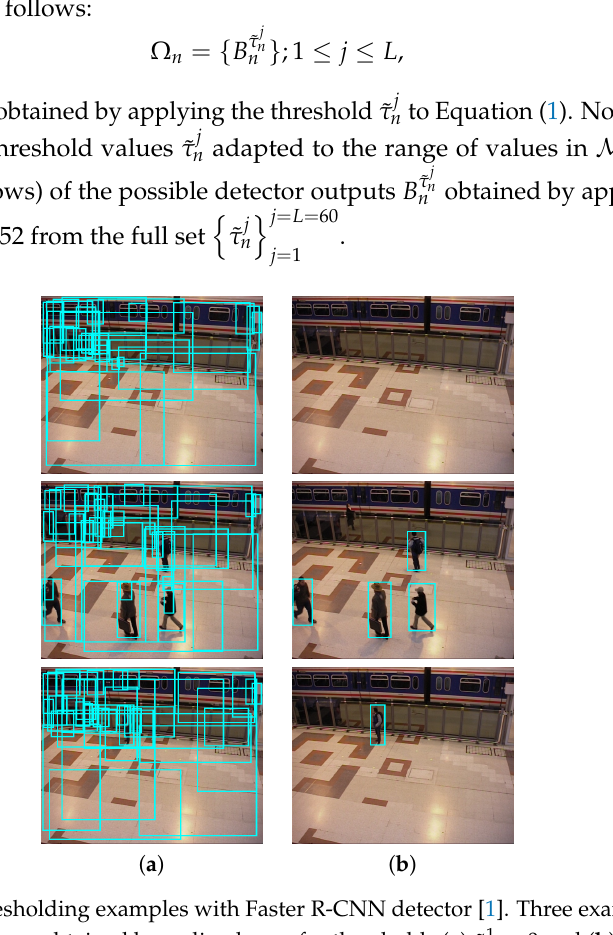
= 0 and ( b ) ˜ τ 52 = 0.85 from 1 1